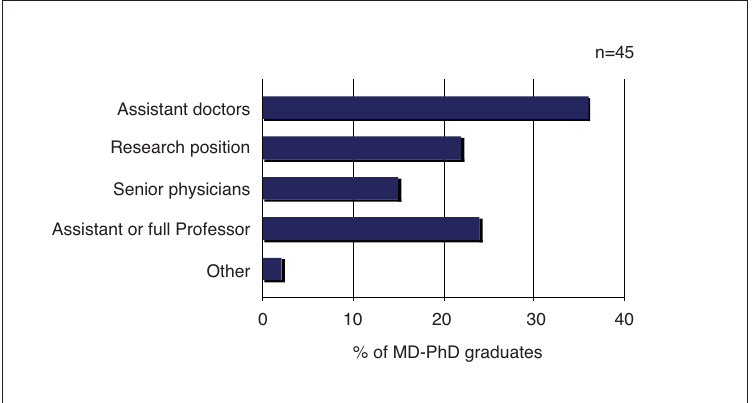
Career track: Current employment of MD-PhD graduates.